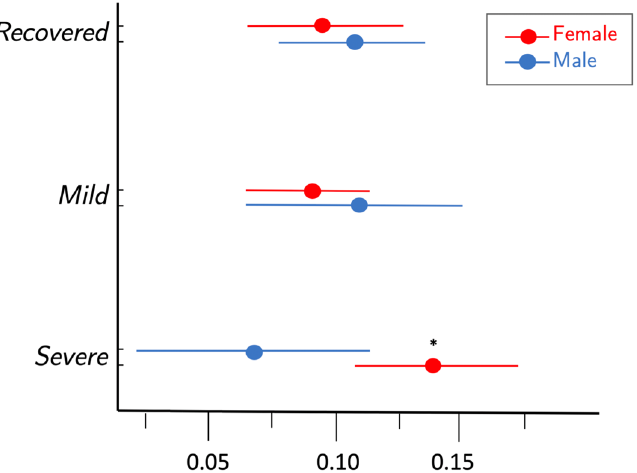
Figure 1. Least square mean homogeneity index of the magnetization transfer ratio (MTR h ) with 95% confidence intervals from linear mixed model for females and males by recovery status, adjusting for tract (of lateral corticospinal, spinothalamic, spinoreticular, and gracile and cuneate fascicle), intervertebral disk (C2/3, C3/4, C4/5, C5/6), side, BMI, and age. * p < 0.05 compared to females in recovered and mild groups and males in the severe group.